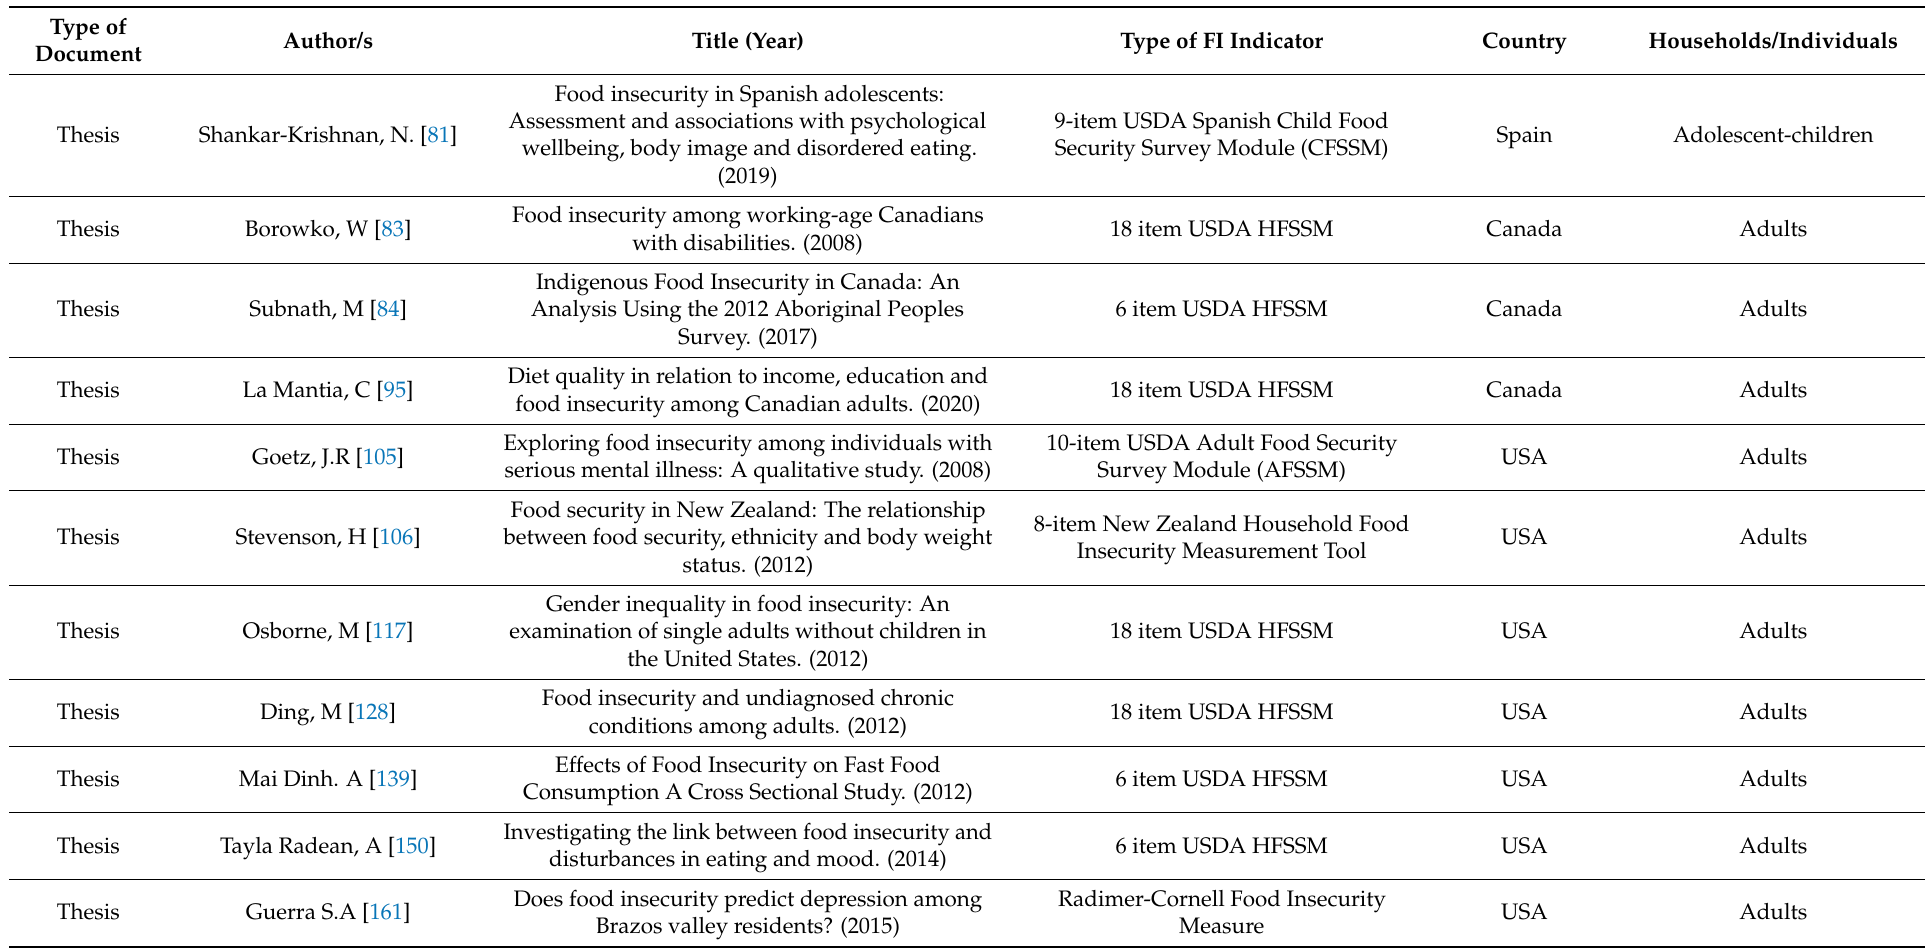
Table 2. Overview of Grey Literature in food insecurity studies, theses, reports, conferences and